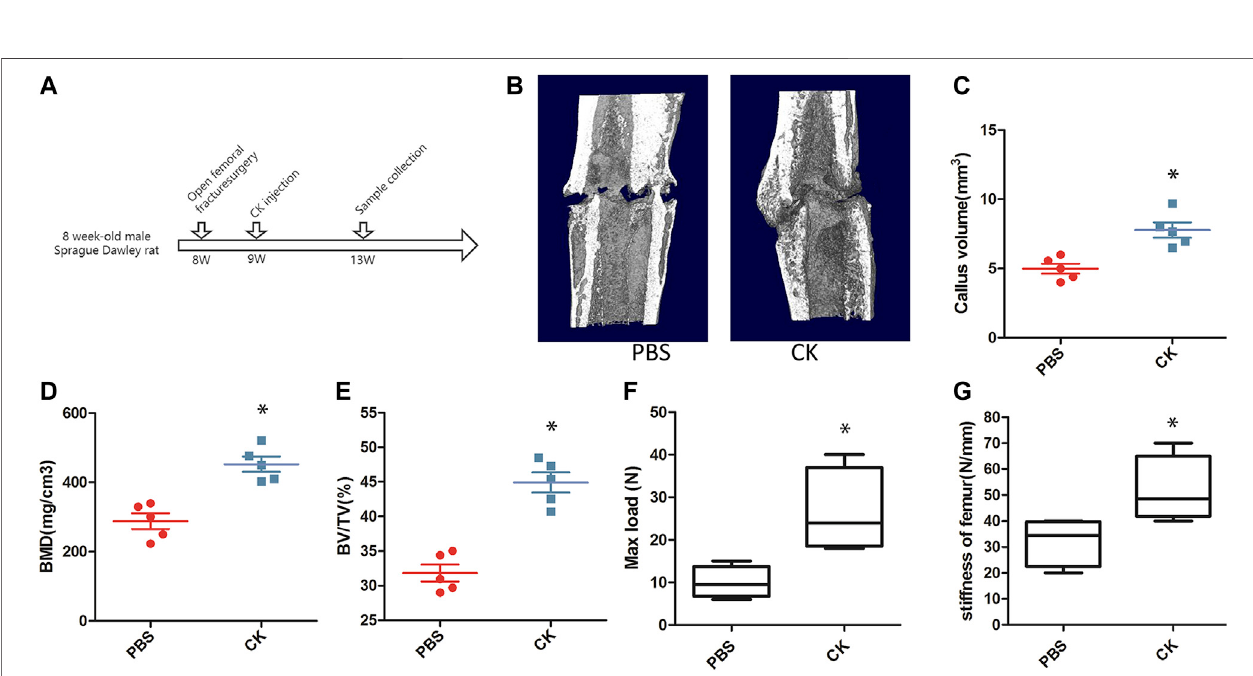
FIGURE 3 | CK accelerated the progression of fracture healing. (A) Schematic illustration of time points of animal modeling and sample collection. (B) Representative 3-dimensional micro-CT images of femurs in each group. (C – E) Quantitative analysis of parameters, including CV, BMD, and BV/TV, * p < 0.05, compared with the PBS group, n = 3 (F – G) Biomechanical properties of the fractured bones by 3-point bending test, * p < 0.05, compared with the PBS group, n = 6.